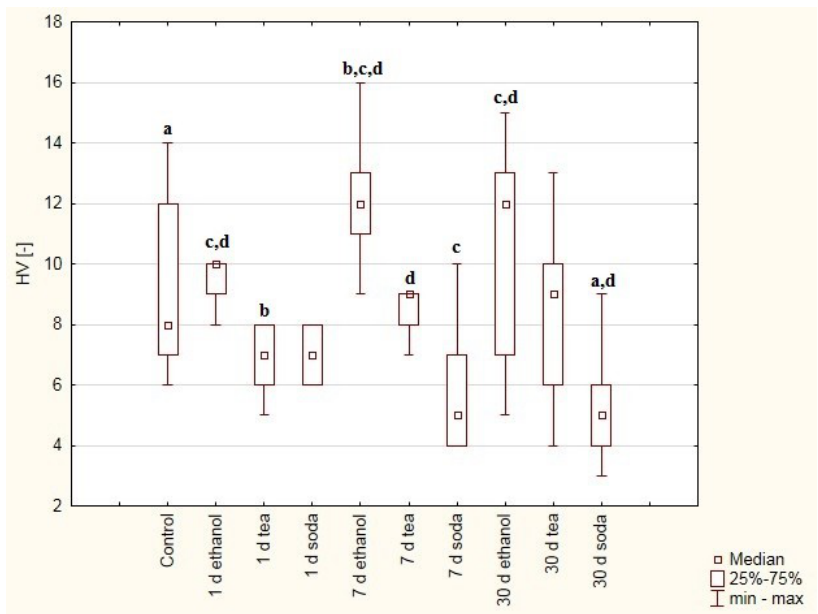
Figure 2. Box and whiskers plot of Vickers hardness. Values were obtained for samples made of Adhesor Carbonfine cement treated with ethanol (75%), green tea and baking soda (2.5%) solutions after one, seven or 30 days and samples immersed for seven days in distilled water as control. Statistically significant differences were detected between: (a) Control group vs. 30 days in soda solution, (b) 1 day in tea solution vs. 7 days in ethanol solution, (c) 7 days in soda solution vs. 1 day in ethanol solution, 7 days in ethanol solution, 30 days in ethanol solution, (d) 30 days in soda solution vs. 1 day in ethanol solution, 7 days in ethanol solution, 30 days in ethanol solution, 7 days in tea solution.